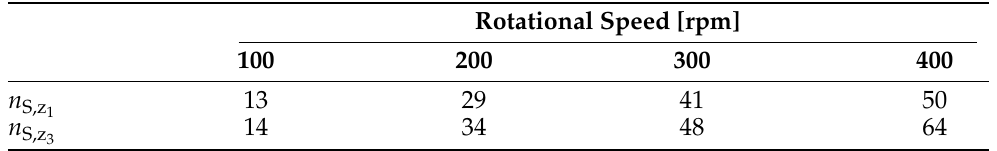
Table 3. Number of signals n S,z damages on z 3 for the respective rotational